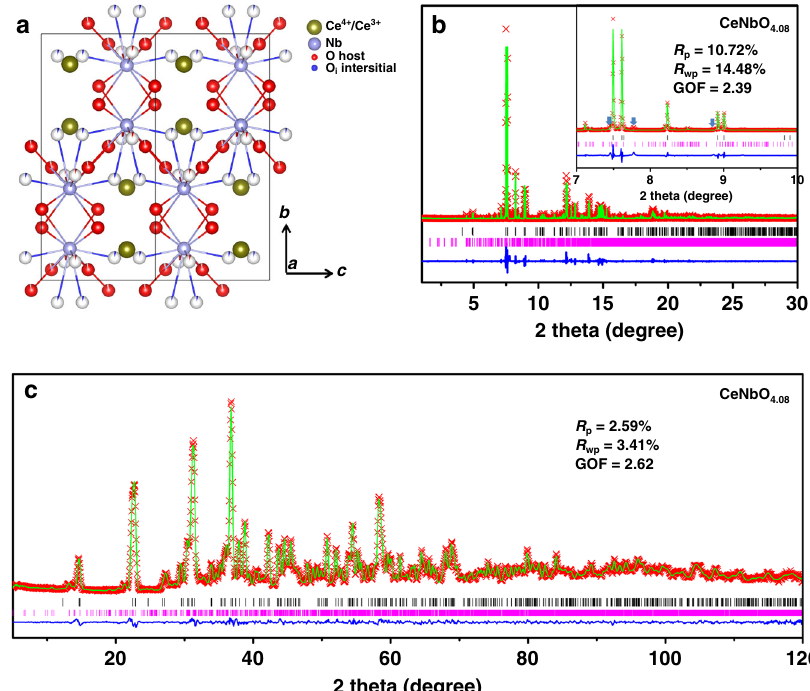
Fig. 3 Structure characterization and analysis of CeNbO 4.08 . a Average structure of the (3 + 1)D incommensurately modulated structure of CeNbO 4.08 along the [100] p direction. The interstitial O3 (blue atom) is located between Ce cations within the Ce cationic chain. b Final Rietveld re fi nement against the SPD data for CeNbO 4.08 with (3 + 1)D superspace. Note: the unexplained peaks at 7.46, 7.77, and 8.86 degree (marked at inset pattern) belong to the impurity phase of CeNbO 4.25 . c Final Rietveld re fi nement against the NPD data for CeNbO 4.08 with (3 + 1)D superspace. (Red multi (×) symbol: observed pro fi le, green curve: simulated pro fi le, blue curve: difference pro fi le, black Bragg line: main re fl ections, pink Bragg line: satellite re fl zone axis SAED of CeNbO 4.08 indicated that the structure can be described as monoclinic (3 + 1)D incommensurately modulated with a single modulation vector q = 0.069 a * + 0.175 c * and a nonstandard centering X = (½, ½, ½, ½). However, satellites up to order 5 or even 7 are needed to describe the whole pattern (Supplementary Fig. 3b). The qualities of the LeBail fi t of SPD are similar for the 2D modulation and 1D modulation, which further con fi rmed that the 1D modulation is the correct description (Supplementary Fig. 4). It is extremely unlikely that a single